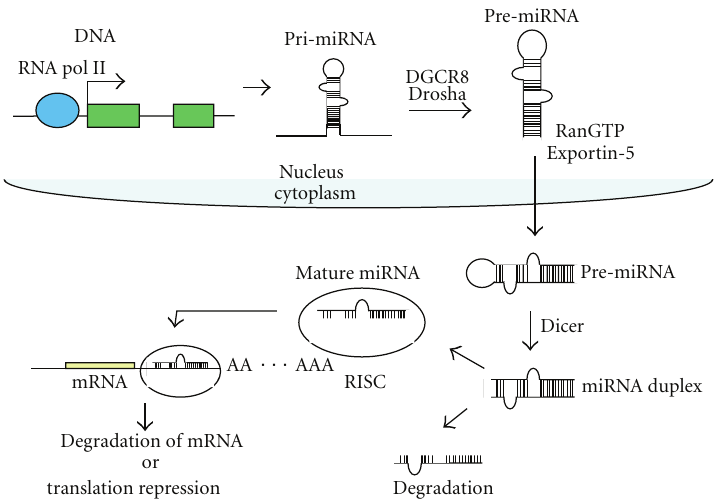
Figure 1: Schema of miRNA biogenesis. Primary miRNA (pri-miRNA) is transcribed by RNA polymerase II. Drosha-DGCR8 complex cleaves pri-miRNA into hairpin-loop structural pre-miRNA. Pre-miRNA is exported to cytoplasm by exportin-5 and RanGTP, then Dicer processes into miRNA duplex. One of the single strands (mature miRNA) is incorporated into RISC and binds to 3 (cid:2) UTR of target mRNA, following translational repression or mRNA